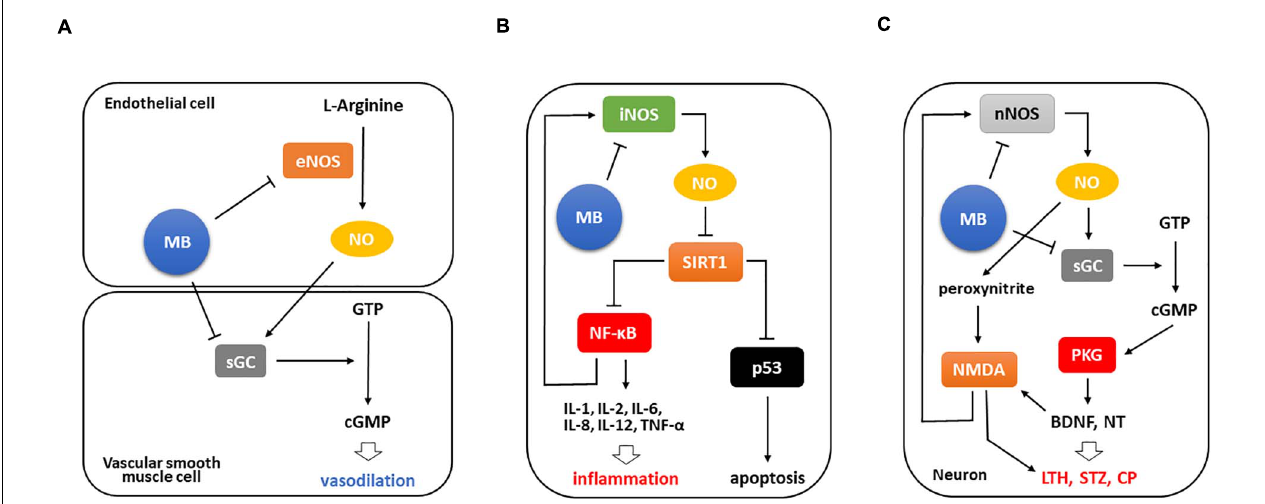
FIGURE 1 | MB is involved in anti-inflammation by suppressing iNOS/NO-NF- κ B pathway. (A) Basically, MB downregulates both eNOS and sGC that are major factors converting GTP to cGMP, ultimately leading to vasoconstriction. (B) Upon tissue injury, iNOS functions as a strong inflammatory mediator in different types of cells. It inhibits Sirt1 activation by NO-mediated S-nitrosylation, which in turn activates NF- κ B and p53 to facilitate inflammatory cytokine expression and apoptosis, respectively. Of note, NF- κ B activation intensifies these events by activating iNOS/NO-NF- κ B pathway. Conversely, MB directly abates iNOS expression and moreover decreases the binding of NF- κ B to iNOS promoter, which consequently interrupts this inflammatory signaling. (C) Meanwhile, NMDA receptors are activated during nerve injury and induces Ca 2 + influx, which then results in the excessive expression of nNOS and markedly activates nNOS/NO signaling. The increased NO production stimulates NMDA receptors and triggers NO/cGMP/PKG cascade, which promotes the subsequent BNDF upregulation and neurotransmitter release and ultimately induces long-term hyperexcitability and central sensitization. Notably, BDNF and peroxynitrite potentiate NMDA receptors, which stimulate nNOS expression again. However, MB weakens these responses by inhibiting nNOS and sGC activation, thus may prevent the development of persistent pain.LTH, long-term hyperexcitability; STZ, sensitization; NT, neurotransmitter; CP, chronic